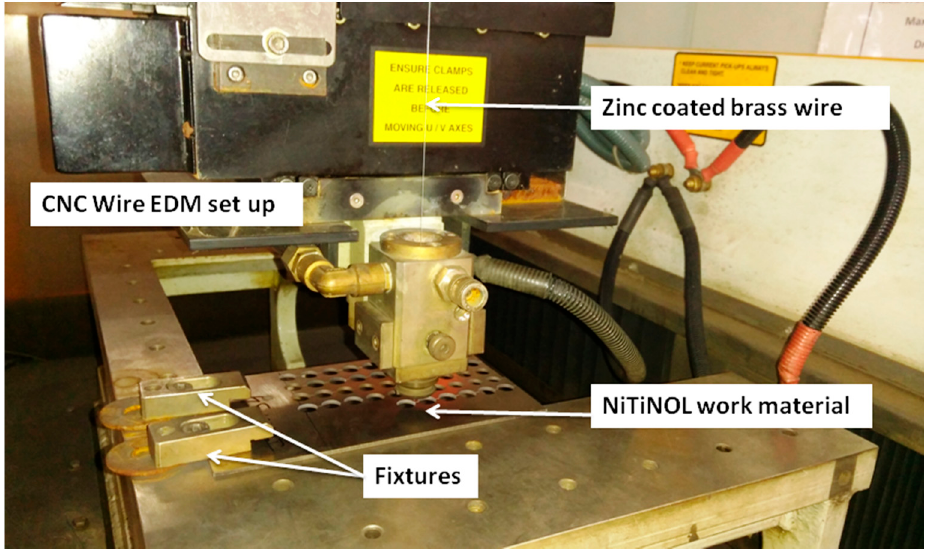
Figure 1. Wire electric discharge machining (WEDM) experimental set up (Courtesy: KLE Technological University, Hubballi, India). University, Hubballi,